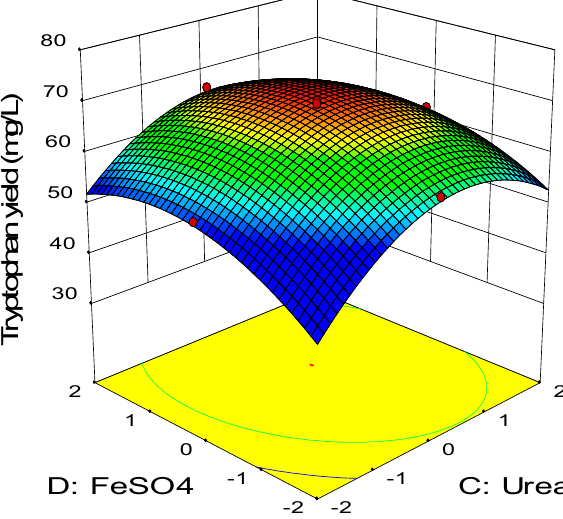
Figure 8. Response surface of tryptophan production by P. acidilactici TP-6 as a function of urea and FeSO 4.